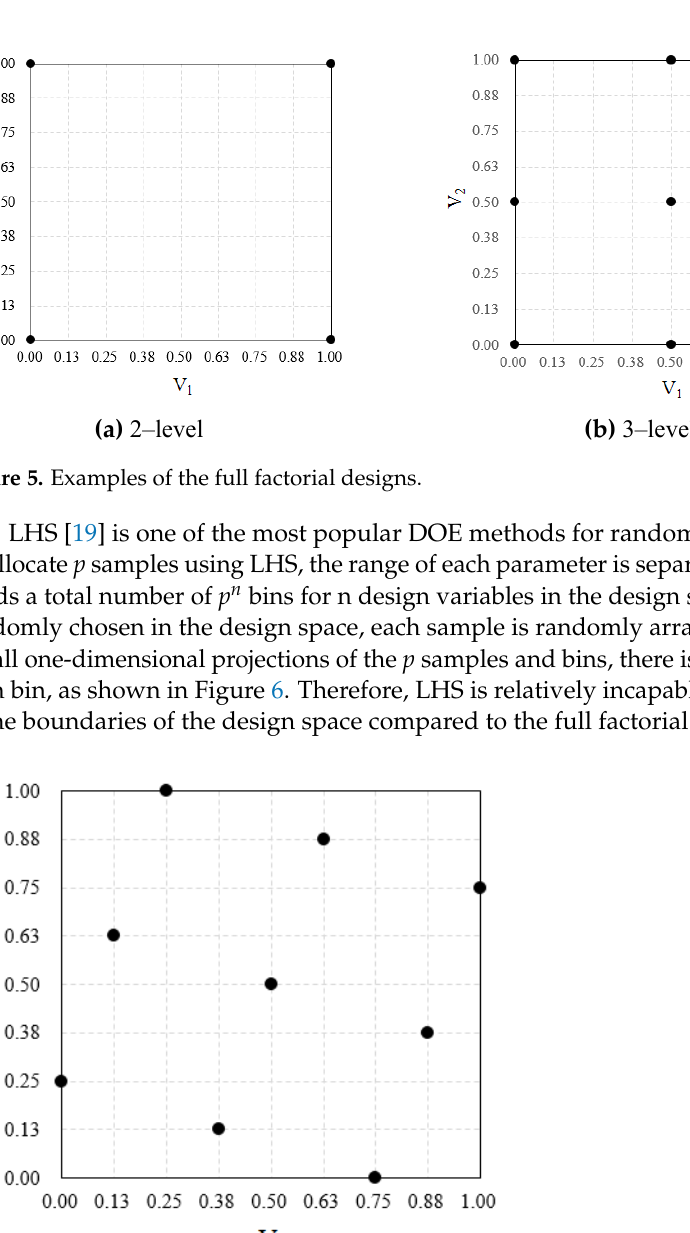
Figure 7. Example of the modified LHS.